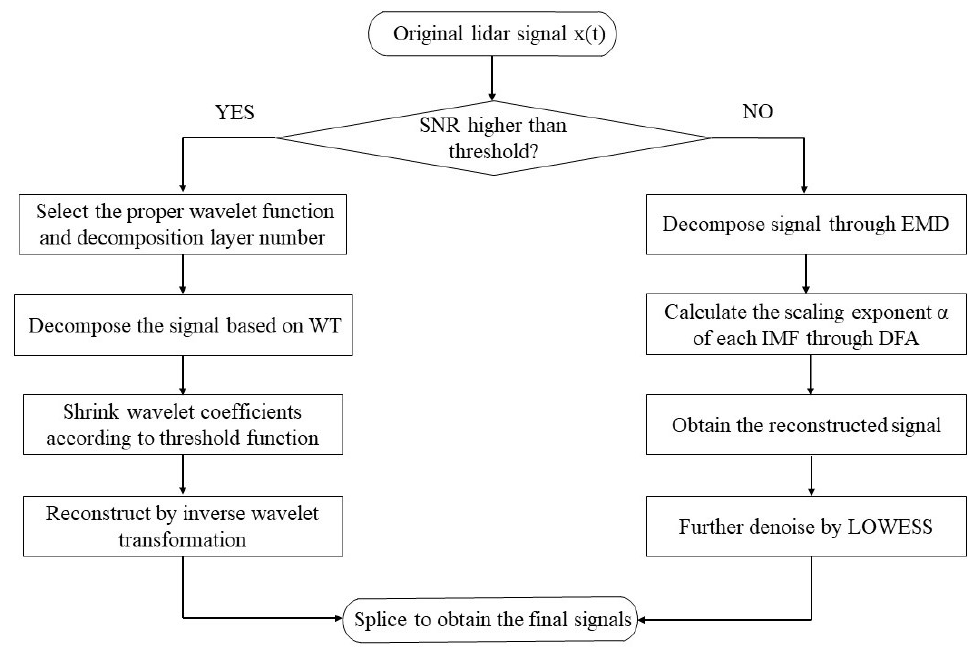
Figure 3. Flowchart of the proposed WT-EEMD-LOWESS